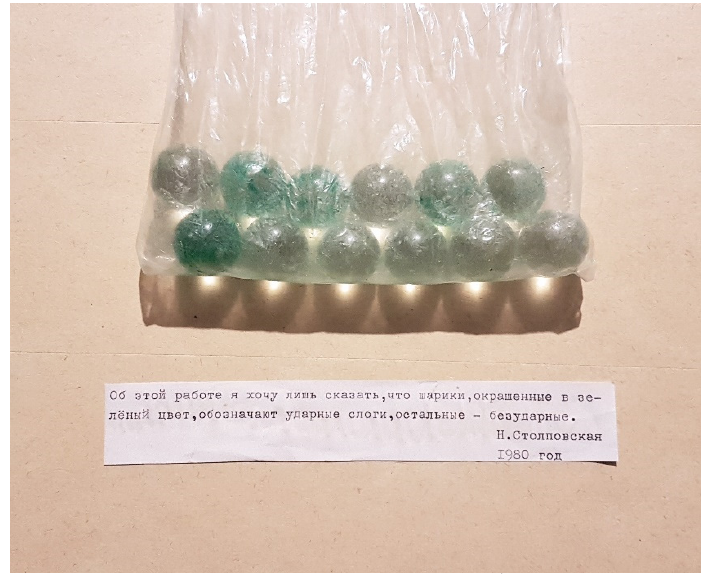
Figure 22. Stolpovskaya. Poem . 1980. Plastic, glass, ink. 31 cm × 15 cm × 4 cm. Courtesy of the artist.